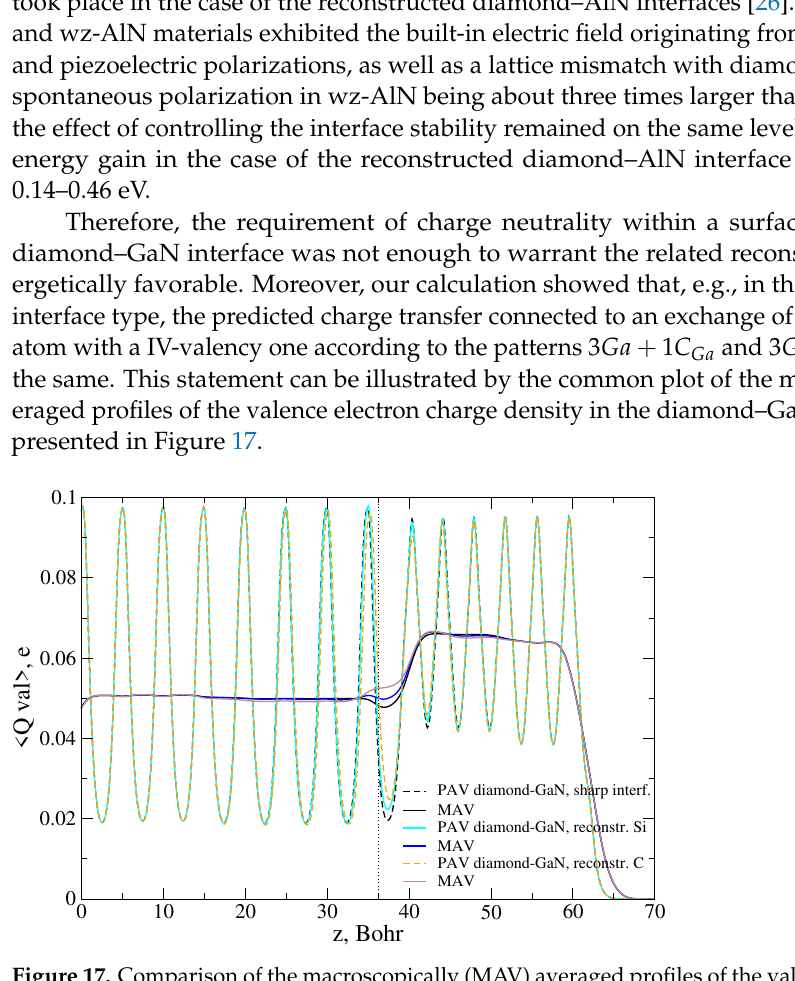
Figure 17. Comparison of the macroscopically (MAV) averaged profiles of the valence electron charge density in the diamond–GaN heterostructure with the Ga-C abrupt and reconstructed interface types, according to patterns 3 Ga + 1 Si Ga and 3 Ga + 1 C Ga . A dotted line points to the average z-th position of the topmost Ga